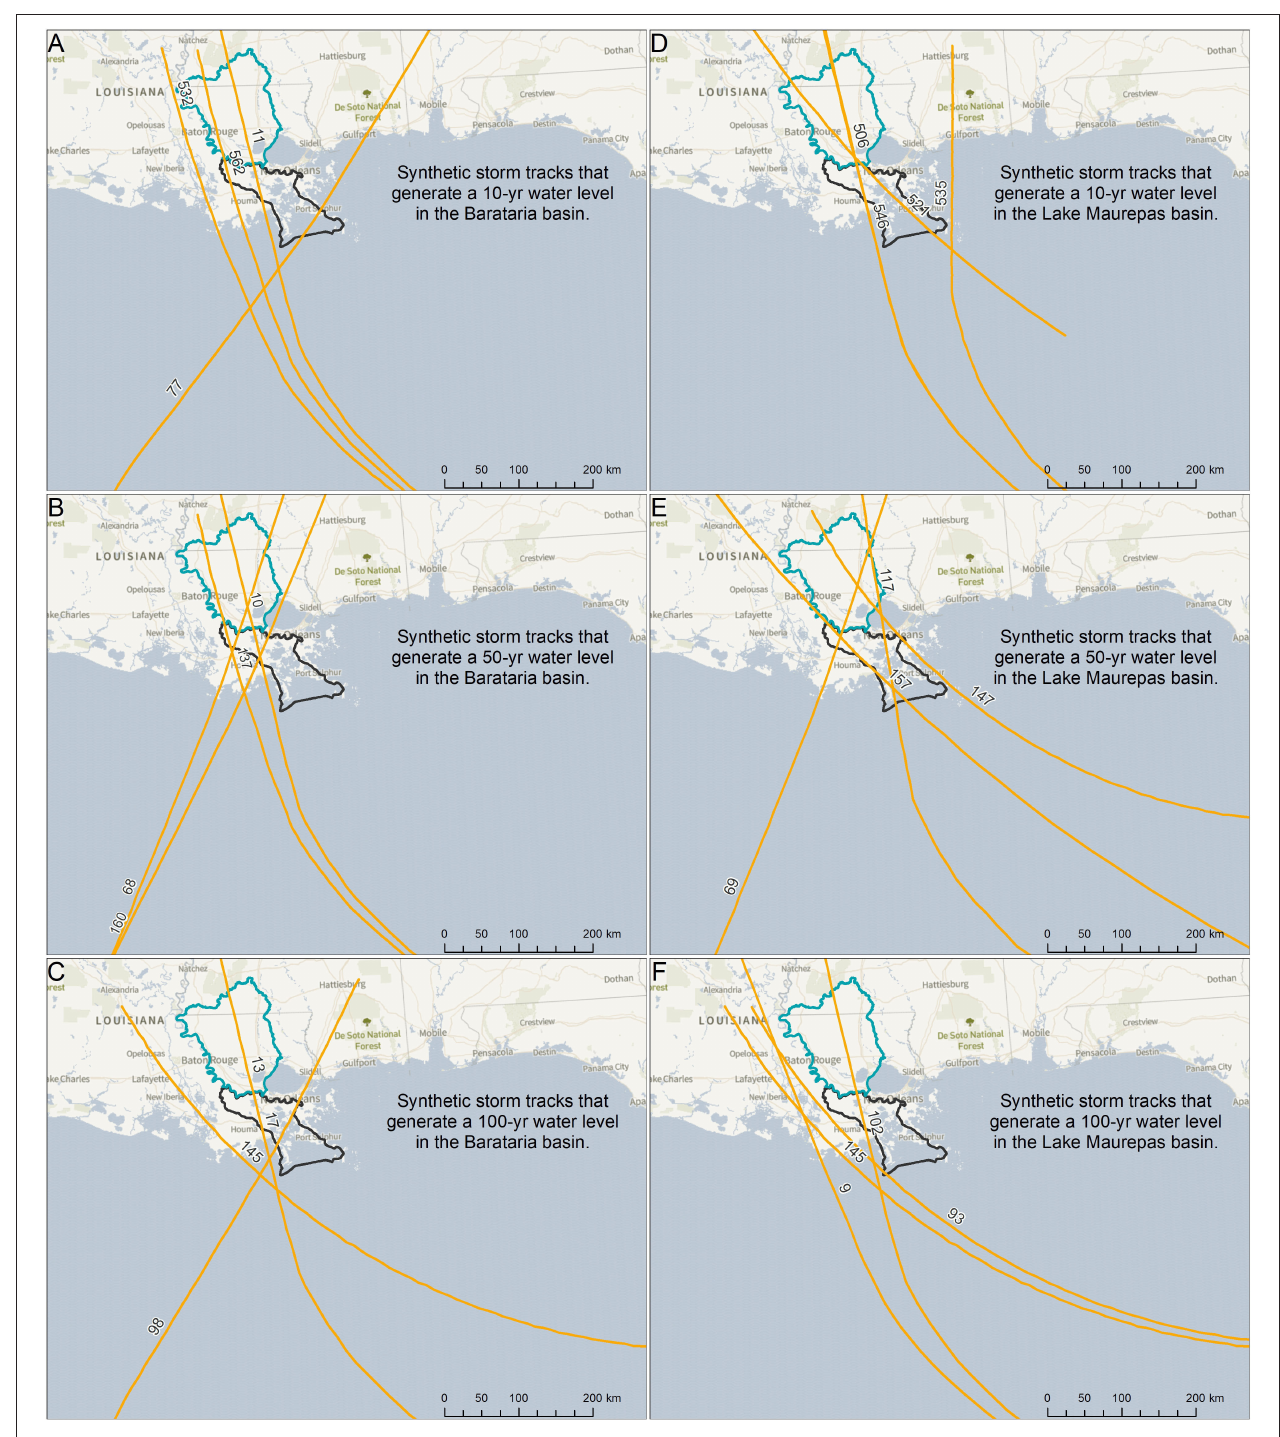
FIGURE 3 | Synthetic storm tracks for the Barataria (A–C) and Lake Maurepas (D–F) watersheds. (A,D) are the storms that cause the 10-year stillwater surge (low), (B,E) the 50-year (medium), and (C,F) the 100-year (high). Storms 506 and 546 in (B) are the same track, but have different storm parameters. Storm parameters are shown in Table 2 . Basemap courtesy of